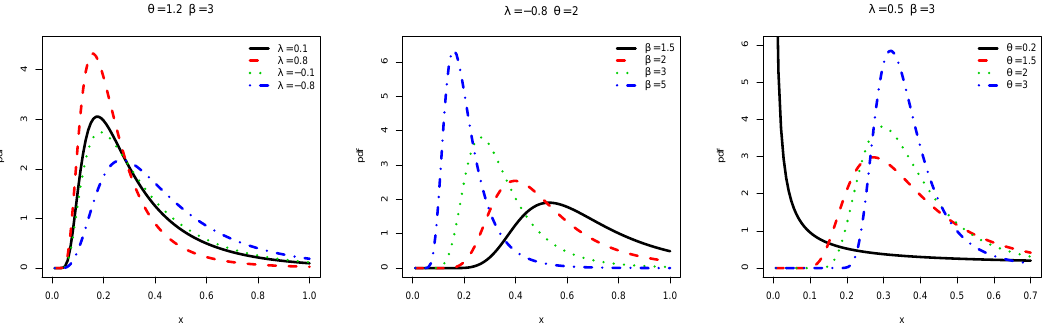
Figure 1. A panel of shapes for the pdf of the transmuted odd Fréchet exponential (TOFrE)